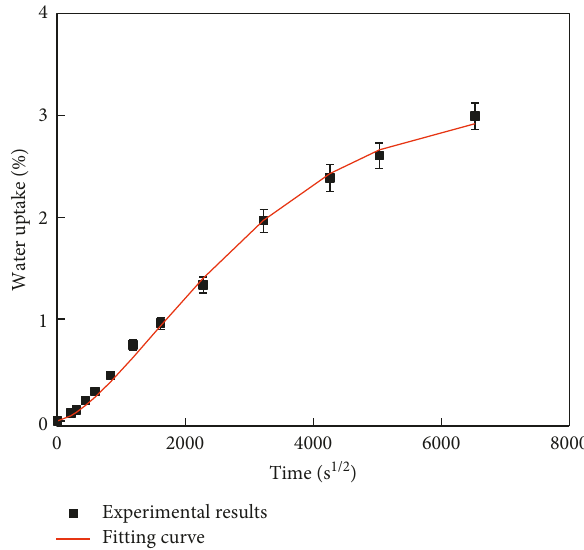
Figure 4: Water uptake curves of the adhesive samples immersed in